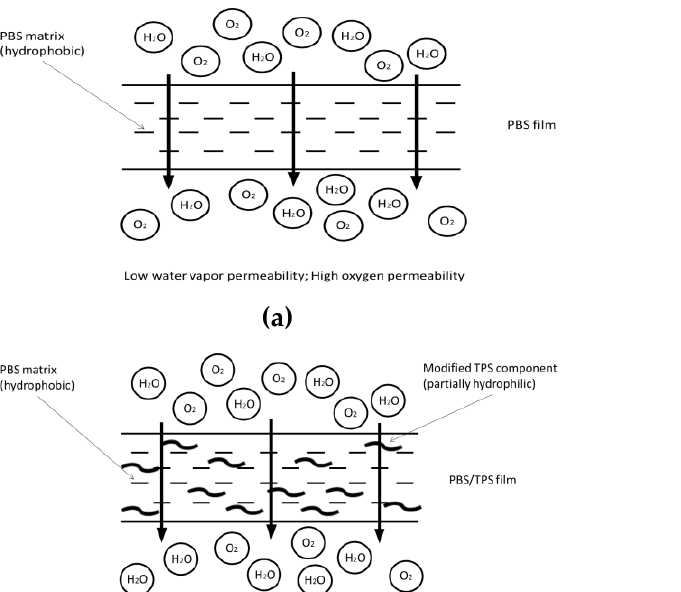
Figure 5. ( a ) Water vapor and ( b ) oxygen gas permeability of PBS films.